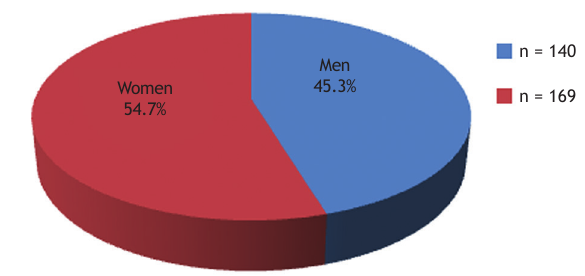
Figure 3 Gender distribution of patients with tinnitus. The chart illustrates the distribution of patients by gender, with 140 men and 169 women.